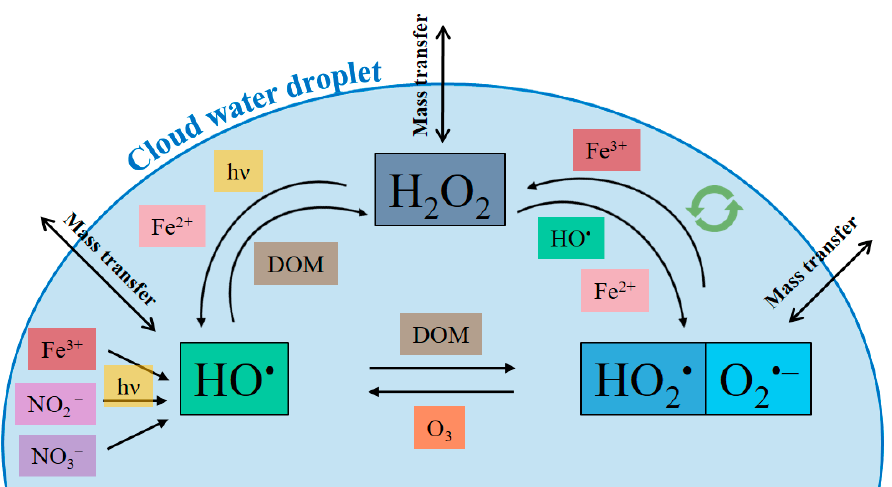
Figure 2. Main HO • generation and destruction pathways. Double circular arrow (light green) means radical recombination. DOM (dissolved organic matter); VOC (volatile organic compounds); h ν means light.